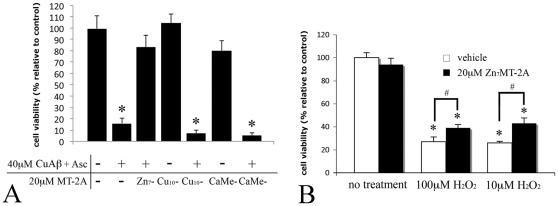
Treatment with 20µM Cu10MT-2A or CaMeMT-2A had no protective effect against 40µM Aβ1–40 (in the presence of 40µM CuCl2 and 300µM ascorbate) (A).Treatment of cortical neurons with 10µM or 100µM H2O2 for two hours resulted in substantial neuronal death, which was not prevented by co-treatment with 20µM Zn7MT-2A (B). Error bars represent standard error of the mean calculated from at least three experimental replicates. In panel A, * - p<0.05 compared to untreated cells (One-Way ANOVA). In panel B, Two-Way ANOVA analysis was performed, and * - p<0.05 compared to untreated cells, # - p<0.05 between treatments.